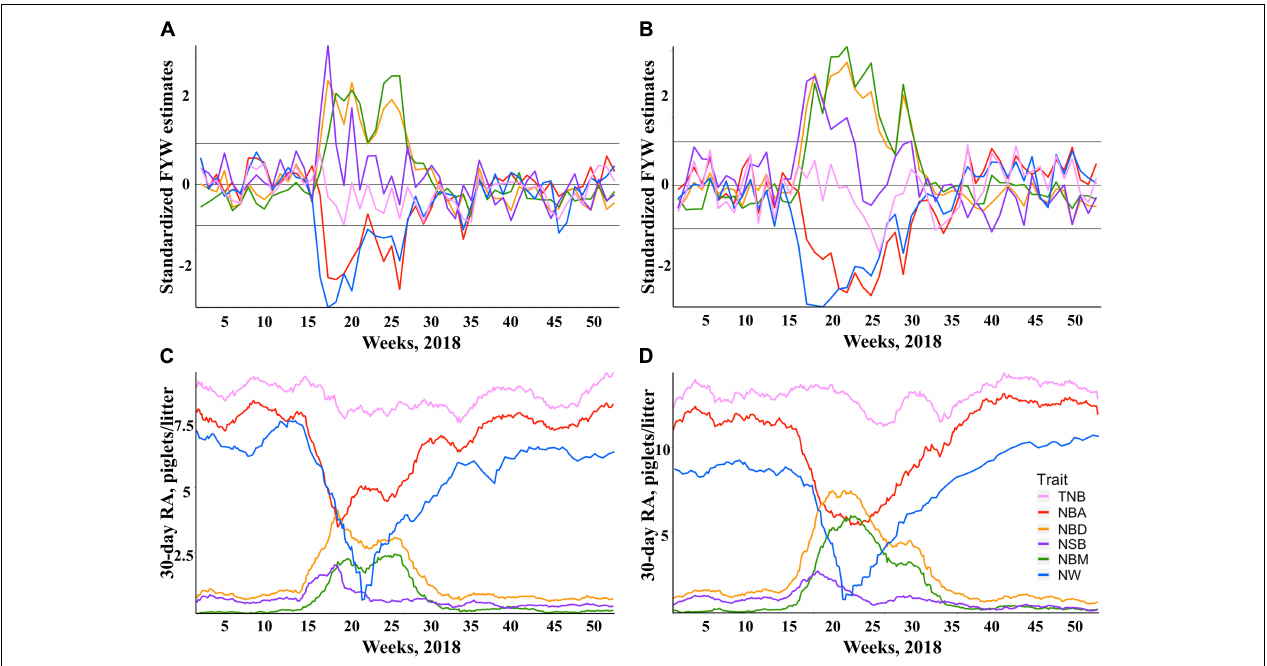
FIGURE 1 | Impact of Porcine Reproductive and Respiratory Syndrome (PRRS) on herd average reproductive performance. Standardized estimates of farrow-year-week (FYW) during 2018 for each reproductive trait for Duroc (A) and Landrace (B) sows. Thirty-day rolling averages (RA) of reproductive traits for Duroc (C) and Landrace (D)